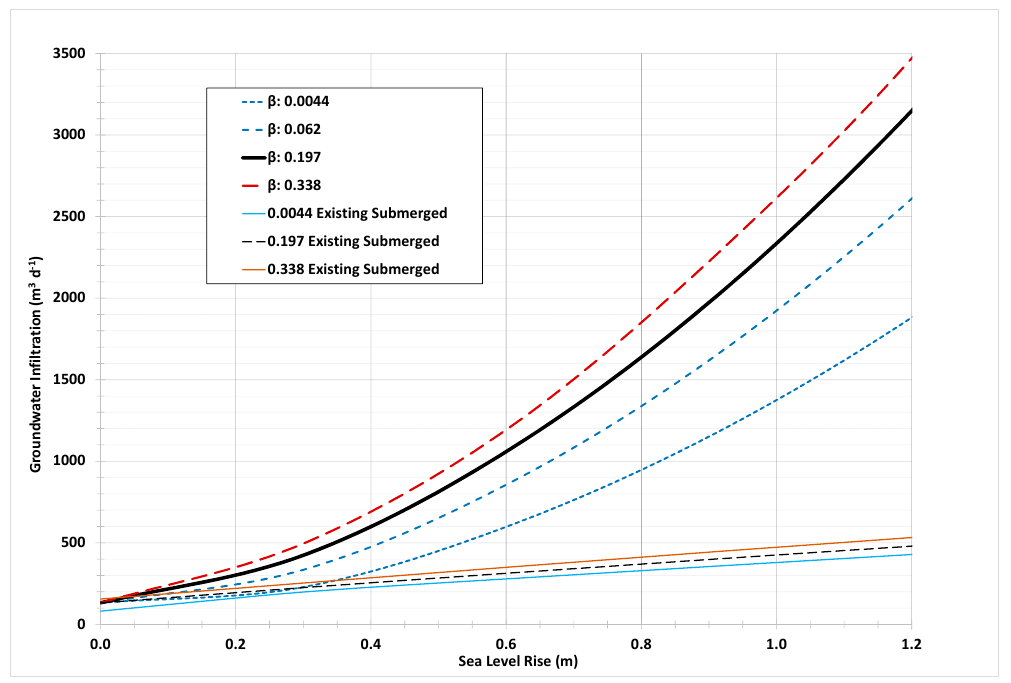
Figure 3. Effects of varying effective β for currently and eventually submerged pipes. 248 Figure 3. E ff ects of varying e ff ective β for currently and eventually submerged Table 4. Projected GWI flows for a range of effective β and SLR of 0.3 to 0.9 m. 249